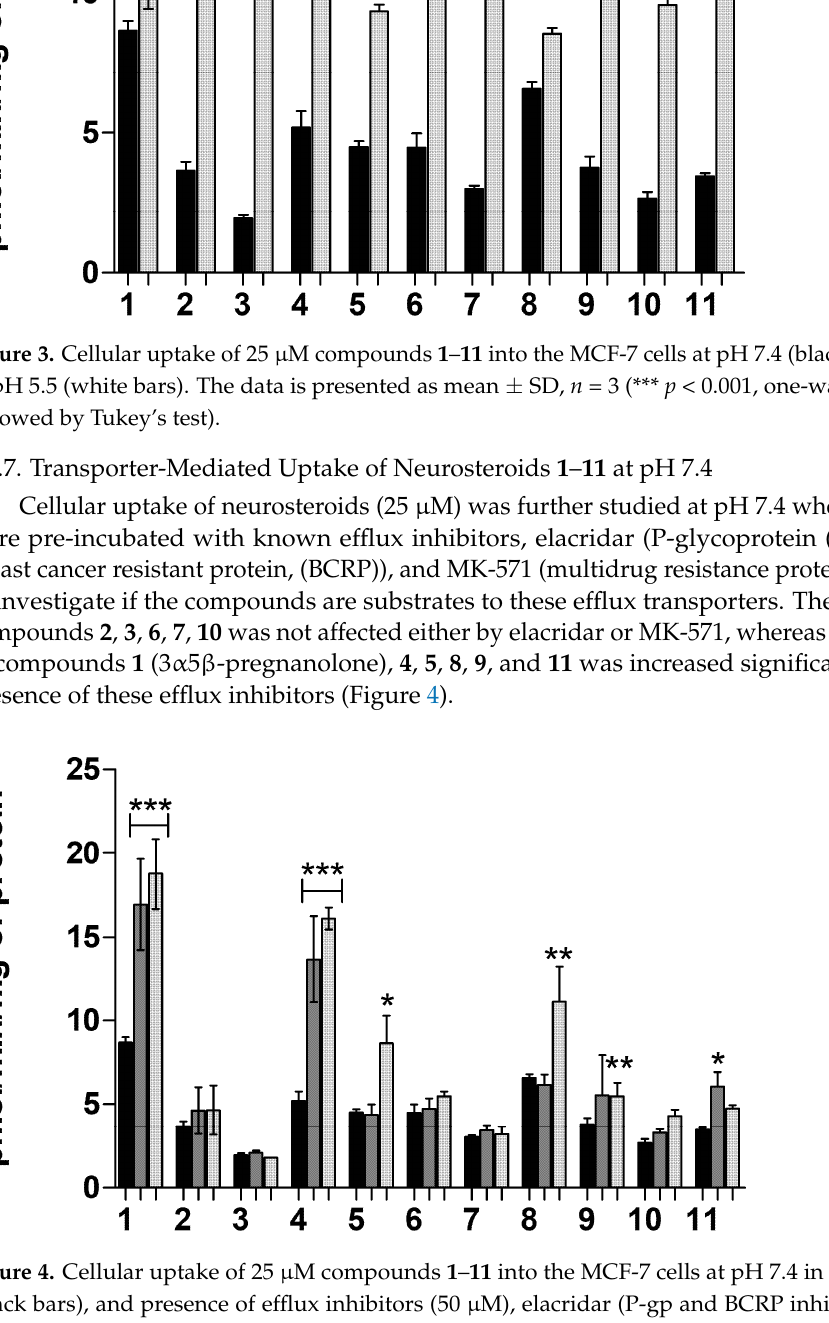
Figure 4. Cellular uptake of 25 µM compounds 1 – 11 into the MCF-7 cells at pH 7.4 in the absence (black bars), and presence of efflux inhibitors (50 µM), elacridar (P-gp and BCRP inhibitor, white bars), and MK-571 (unselective MRP inhibitor, dotted bars). The data is presented as mean ± SD, n = 3 (* p < 0.05, ** p < 0.01, *** p < 0.001, one-way ANOVA, followed by Tukey’s test).